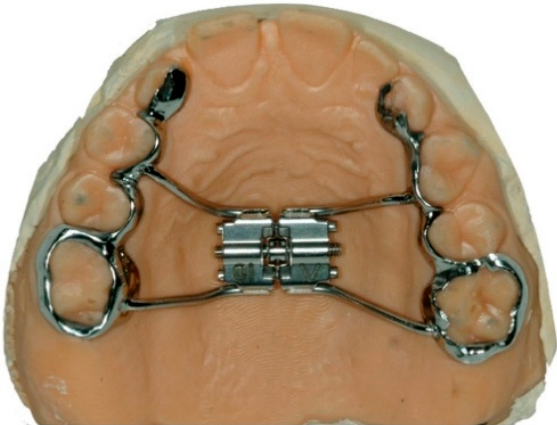
Figure 3. RPE welded to laser melting bands on a plaster model.